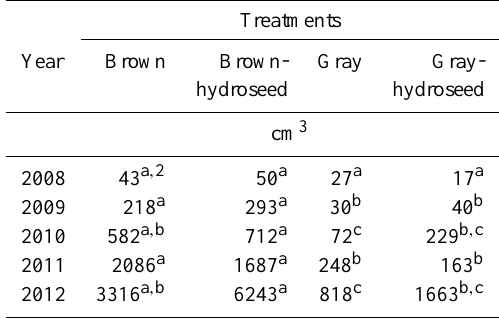
Table 4. Mean ground cover on four soil treatments in 2012 at the Arch–Birch River mine in Webster County, WV (Wilson-Kokes et al.,